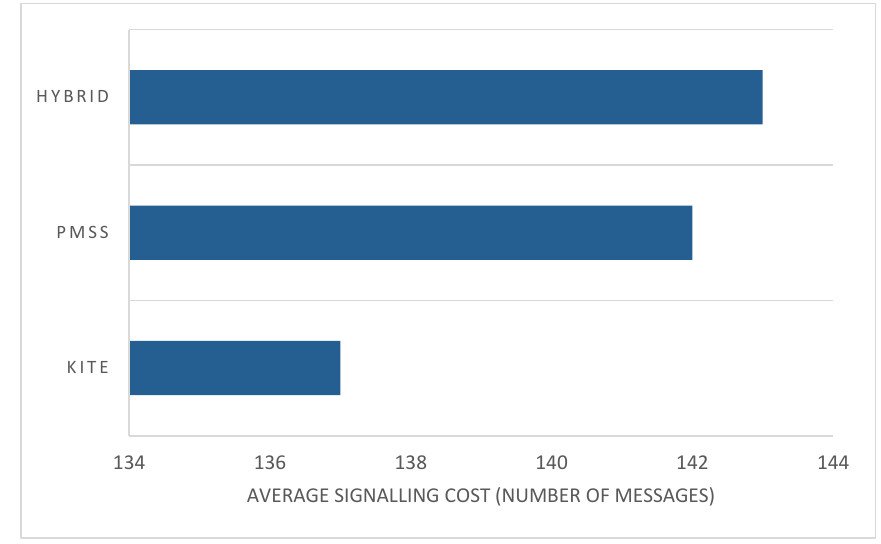
Figure 10. Average signaling by each method.